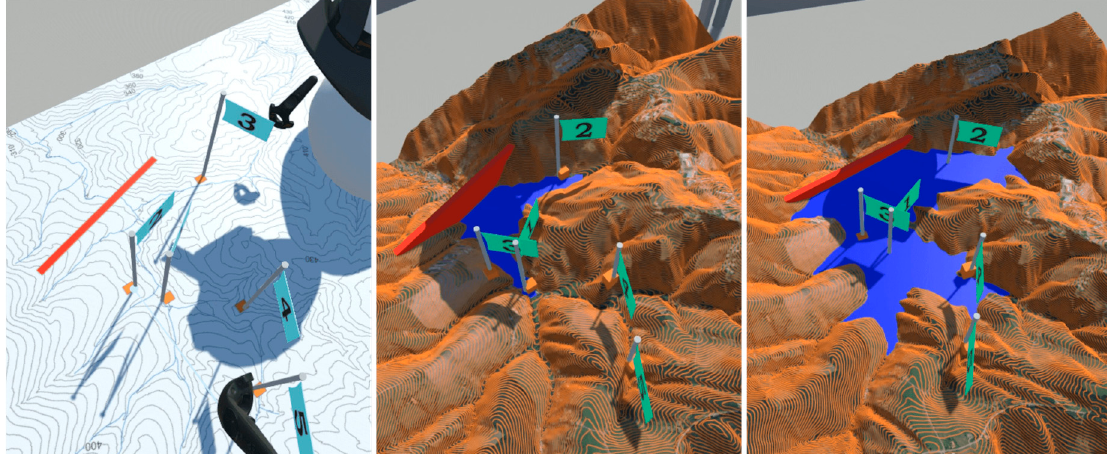
Figure 4. Flooded valley educational task in the CIVE. Left —flags with numbers are placed onto the 2D contour line map, middle —water level starts rising in the 3D visualization, and right —3D visualized dam is completely flooded.